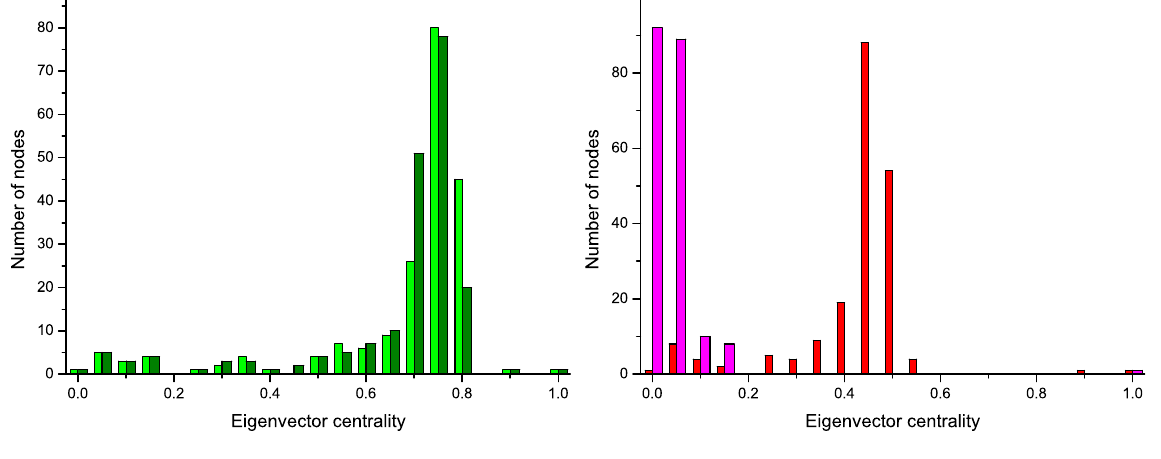
Figure 4. Histograms of the eigenvector centrality of nodes of networks represented in Figure 2, i.e ., two control subjects (Left) and two GN patients